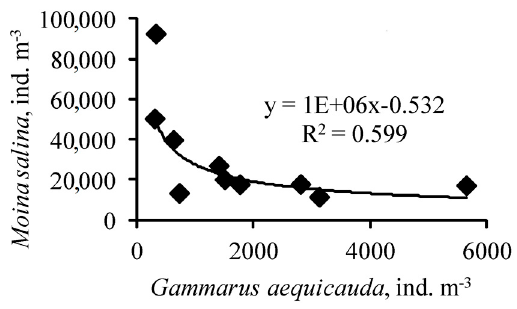
Figure 5. Relationship between changes in the abundance of Gammarus aequicauda and Moina salina in Lake Moynaki during 15–16 September in Lake Moynaki during 15–16 September 2021.